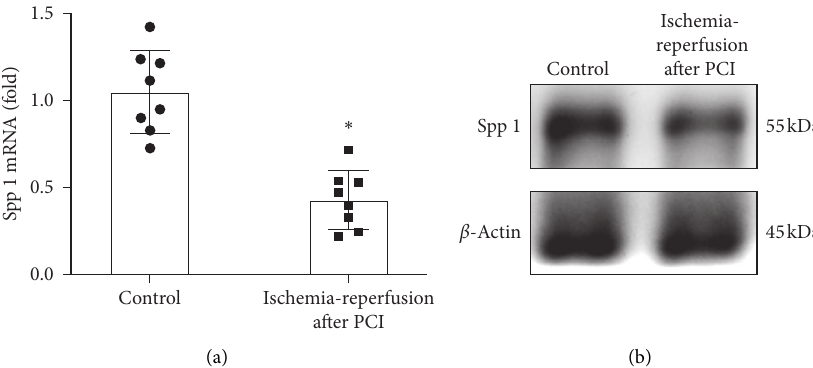
Figure 4: Downregulation of Spp1 expression in ischemia/reperfusion after PCI. (a) qRT-PCR analysis showing the expression of Spp1 in ischemia-reperfusion samples after PCI (square shape) compared to normal samples (circle shape). ∗ p < 0 . 05. (b) Western blot indicating that Spp1 protein levels were significantly downregulated in ischemia-reperfusion cells after PCI compared with normal